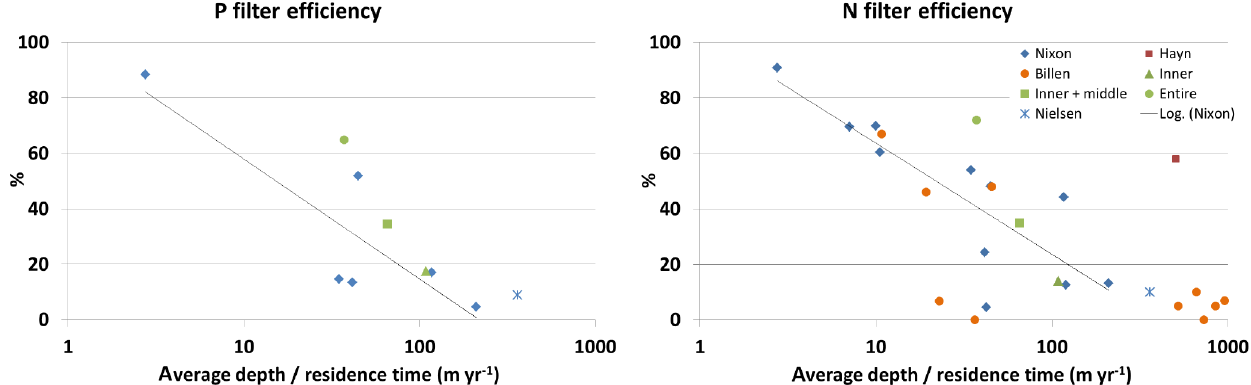
Figure 13. The filter efficiency of P (left) and N (right) vs. the logarithmic ratio between the average depth and the freshwater residence time of the study areas (monthyr − 1 ) . Data from other studies are from Billen et al. (2011), Hayn et al. (2014), Nielsen et al. (2001) and Nixon et al. (1996). The straight line shows the logarithmic regression for the data from Nixon et al. (1996).